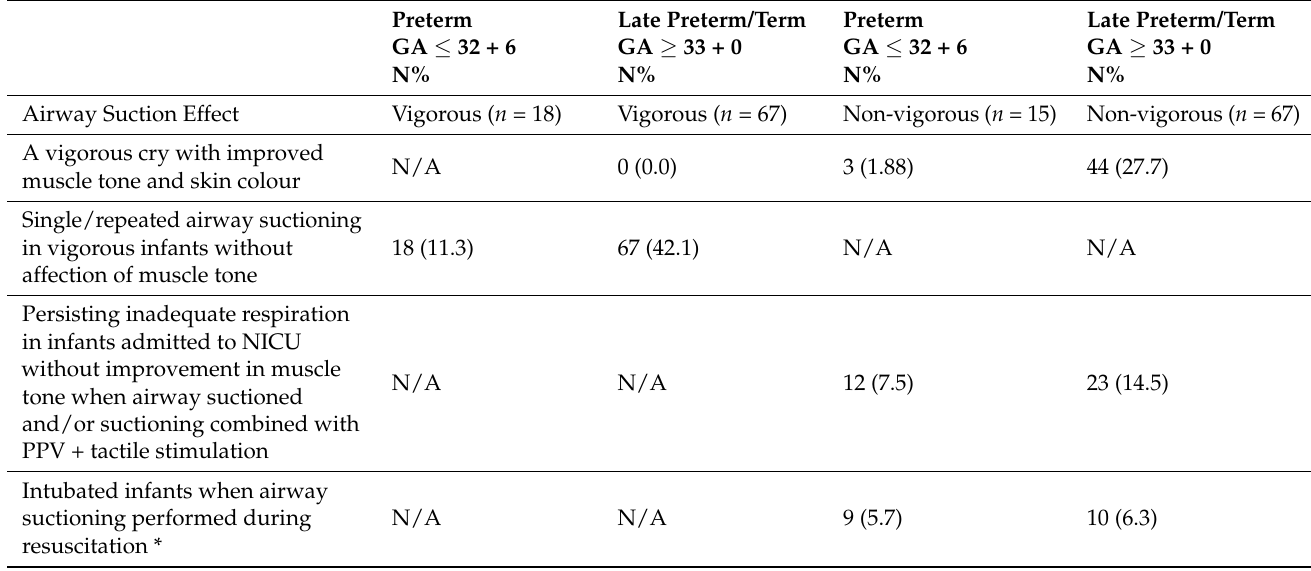
Table 3. Effect of airway suctioning on muscle tone and skin